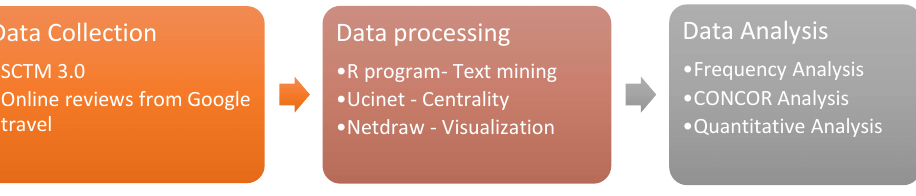
Figure 1. Research Procedures.